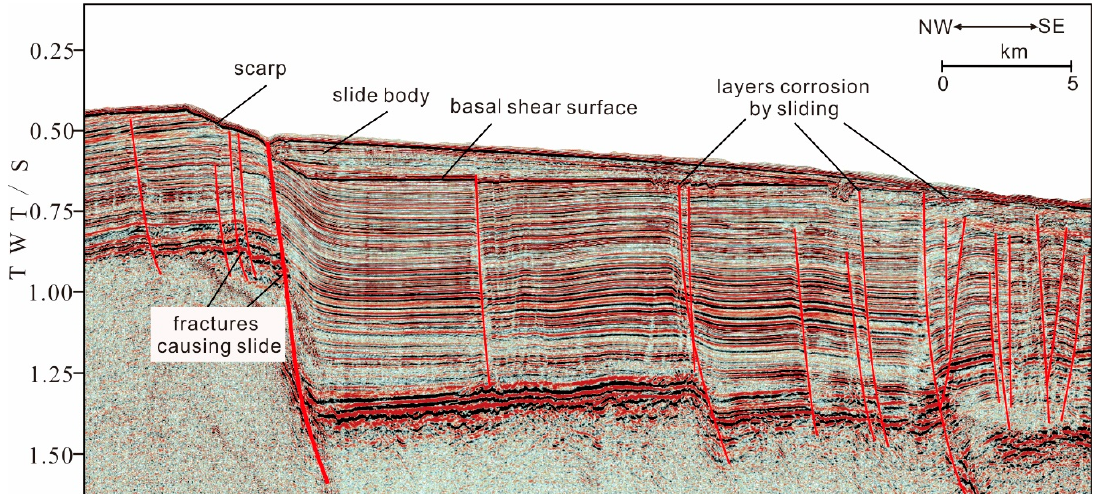
Figure 5. Seismic reflection of Line 4 is a landslide induced by fractures.